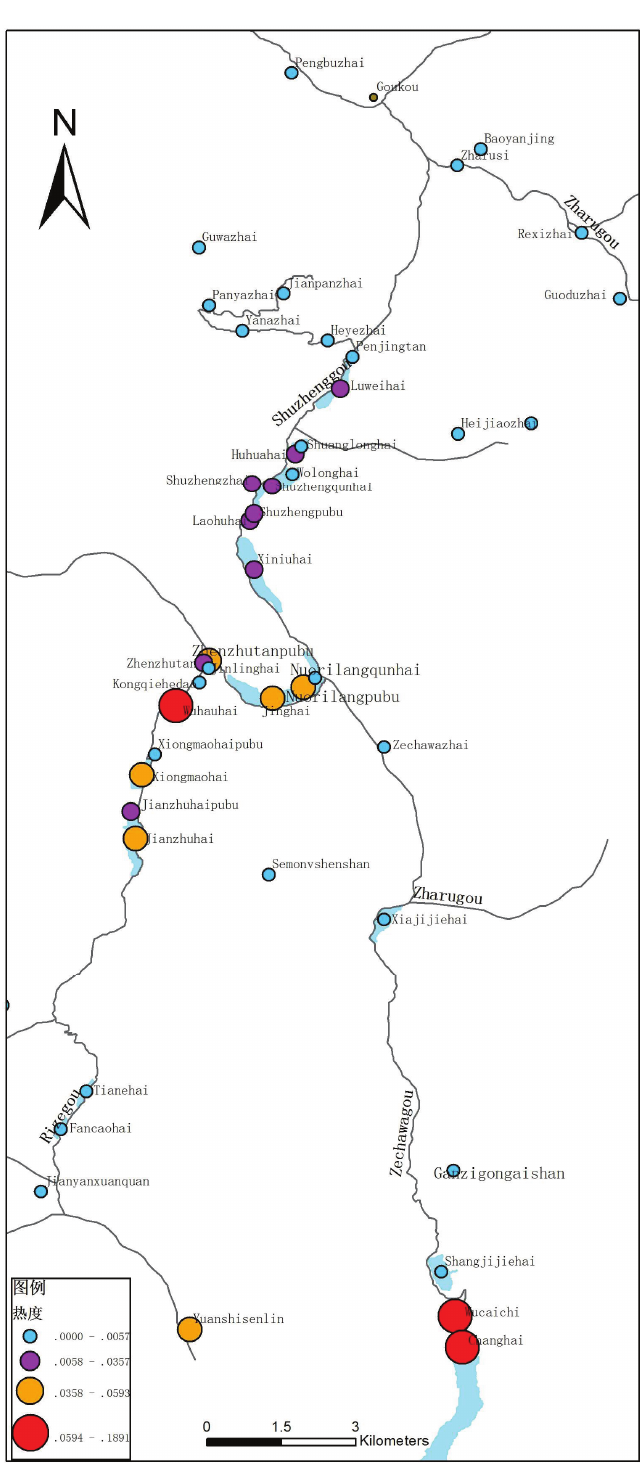
Fig 5. Comprehensive popularity of scenic spots represented by text data granules at the scenic spot scale.